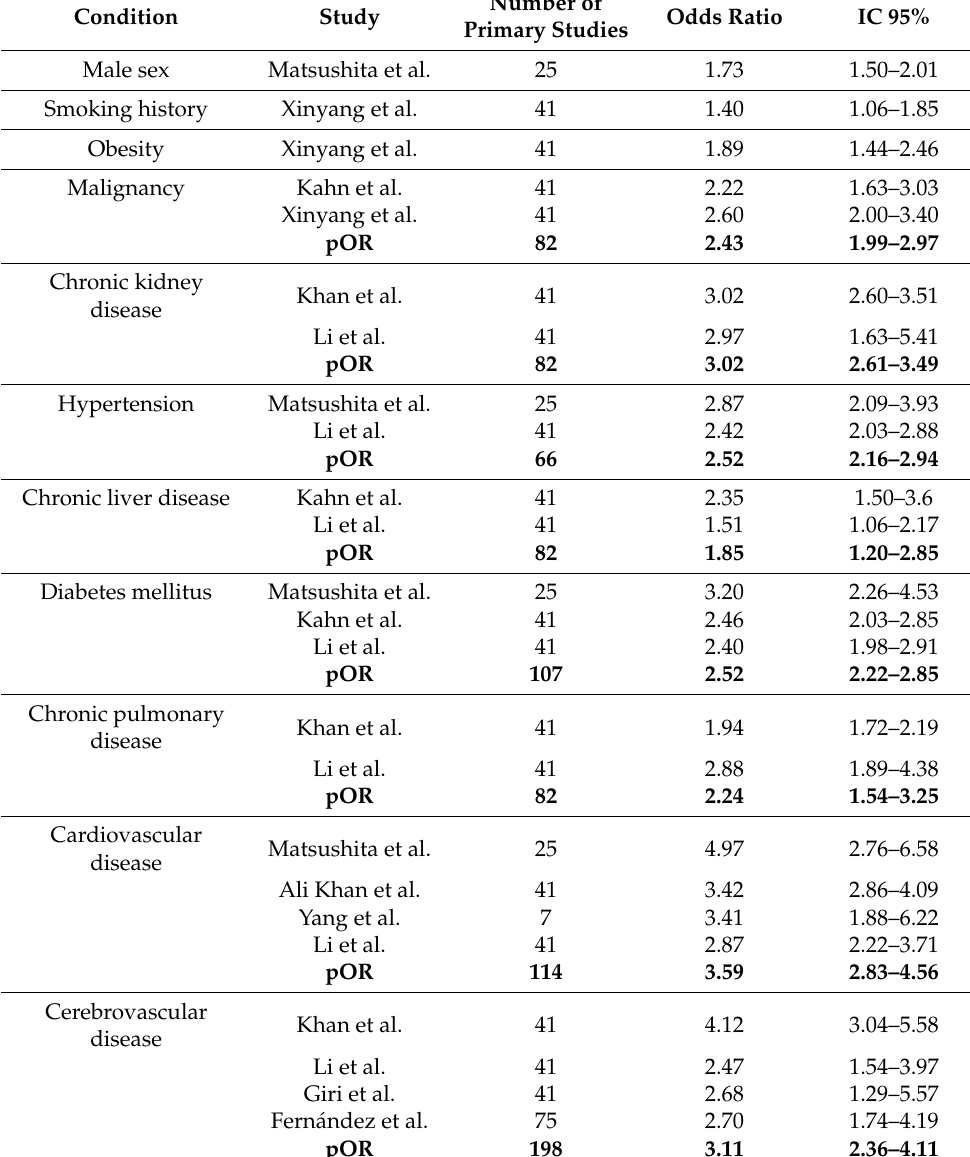
Table 4. Meta-analysis of the different patients’ characteristics and underlying conditions and the risk of mortality due to